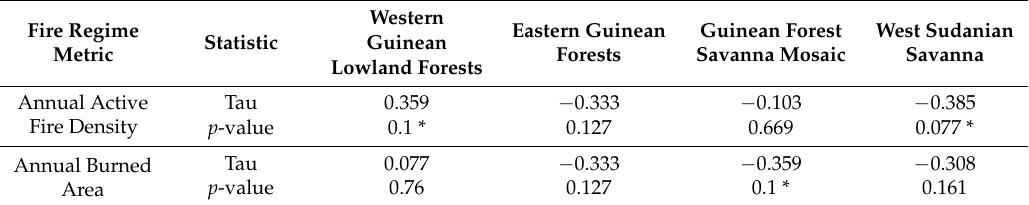
Figure 7. Results of Mann–Kendall trend test of annual: ( a ) MODIS active fire density; ( b ) percent Figure 6. Time series of: ( a ) annual MODIS active fire density; ( b ) total burned area across ecoregions burned area for each grid cell for the period 2003–2015. Cells with p -values less than or equal to 0.1 and the entire study area for the period 2003–2015. are highlighted in the maps. Grid cells without enough data points to calculate trend are shown in white. Table 3. Nonparametric Mann–Kendall tests to detect trends in fire activity at ecoregion scale from 2003–2015. Positive Kandall’s tau statistic values indicate increasing trends, whilst negative values indicate decreasing trends.